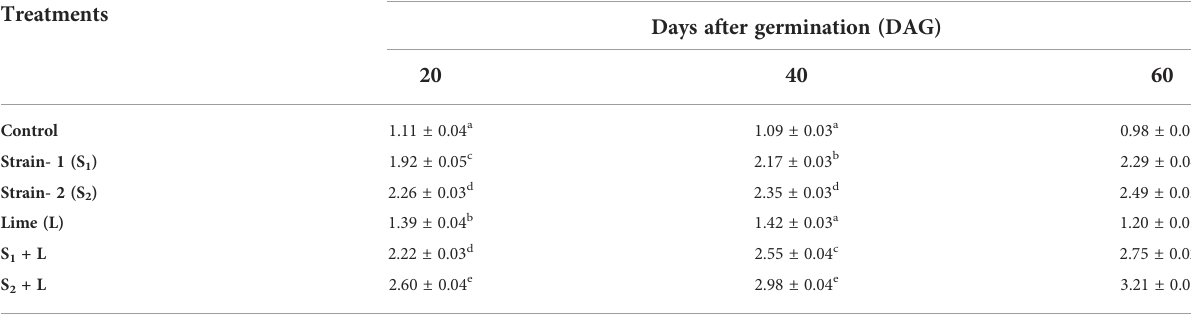
TABLE 2 In fl uence of Rhizobium strains on leaf nitrogen content of French bean.